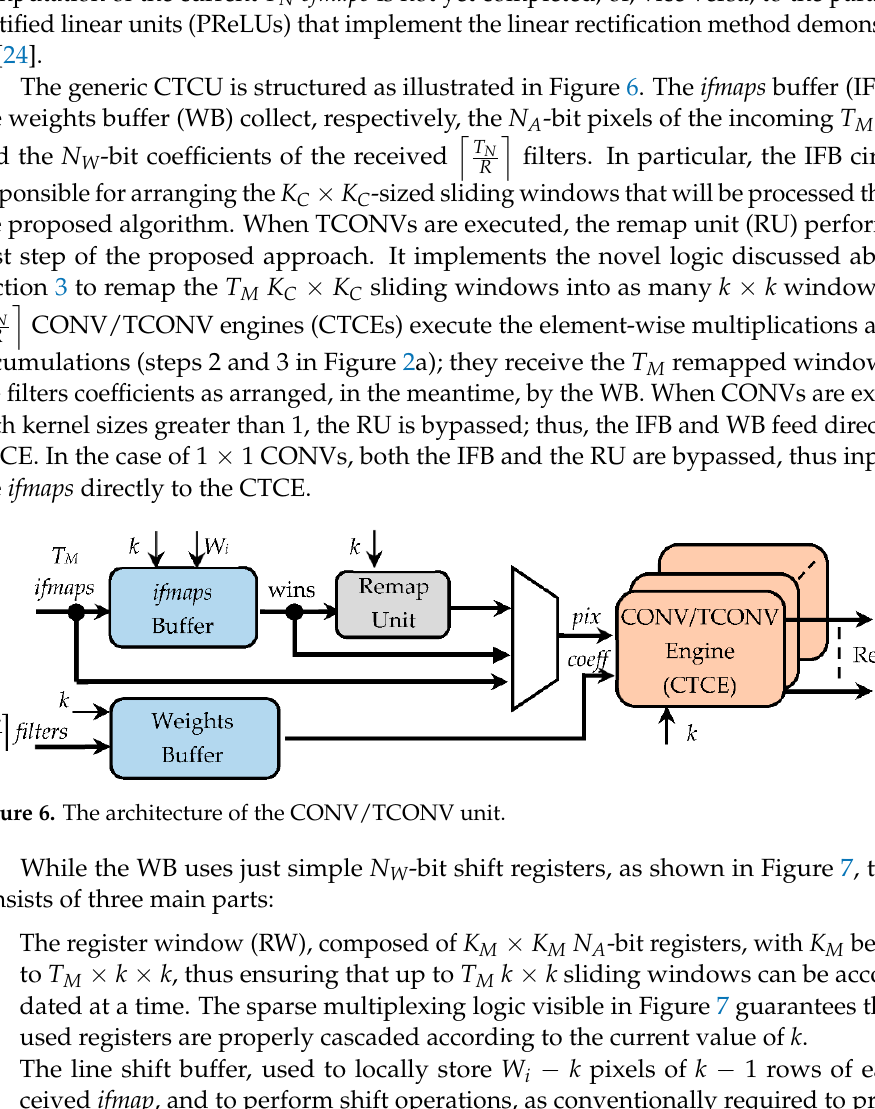
Figure 5. The top-level architecture of the proposed hardware accelerator.